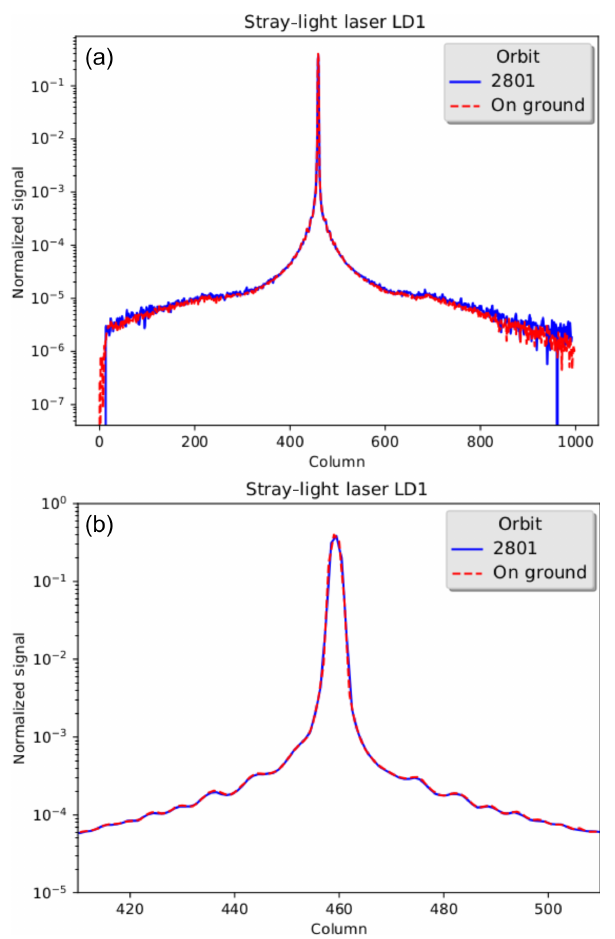
Figure 14. Comparison of in-flight measurements using SLS-1 dur- ing a single orbit with an identical measurement obtained dur- ing ground-based calibration. Panel (a) shows the full image, and panel (b) shows a zoomed in section near the wavelength of SLS-1.